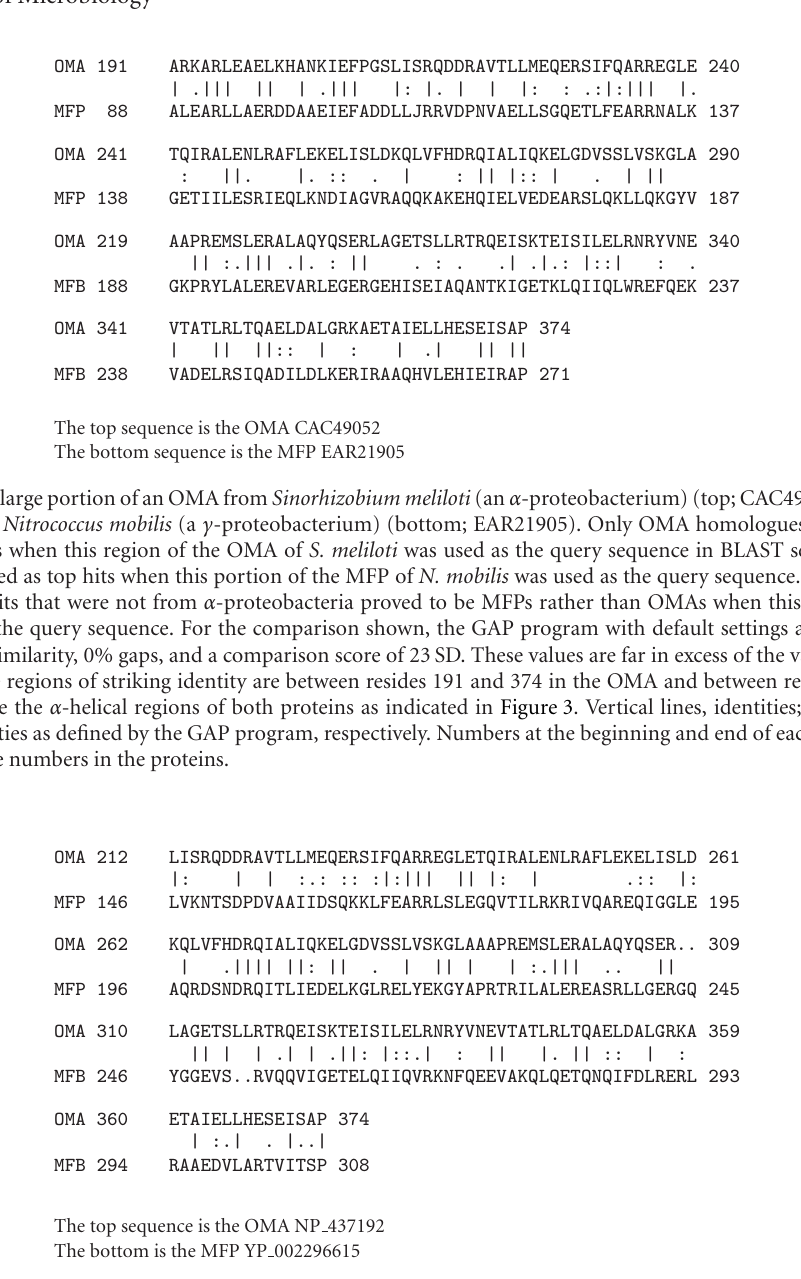
program to contain mixtures of α - and β -structure with a predominance of β